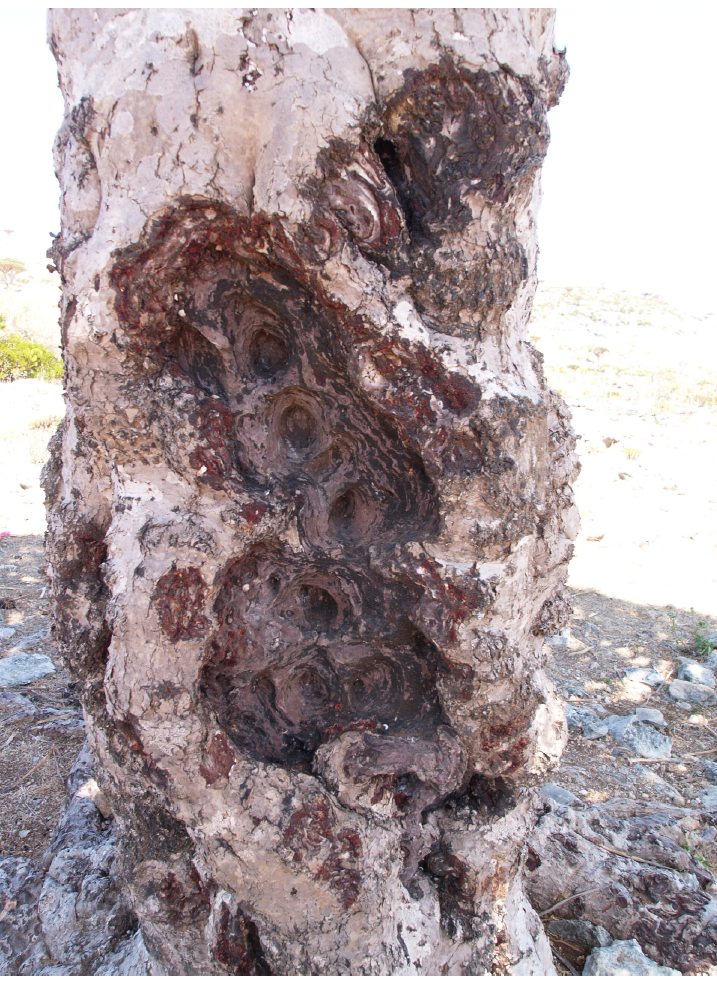
Figure 4. Typical wounded stem of a dragon tree, causing mistakes in repeated DBH measurements (P. Mad ě ra, 2021).